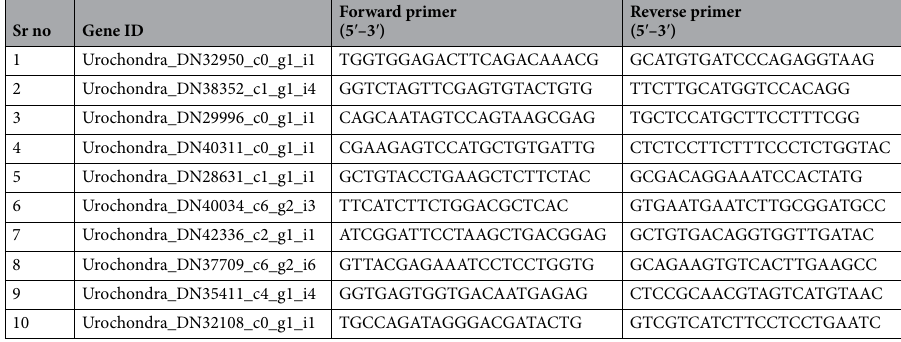
Table 2. List of primers used for qPCR validation.